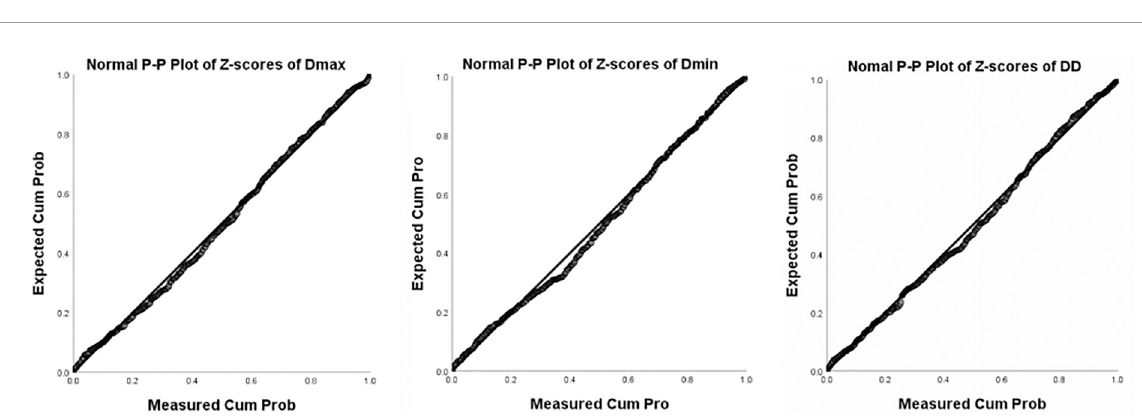
FIGURE3 P-P Plot of Z-scores of Dmax, Dmin, and DD (Diameter Distensibility) based on gestational age.